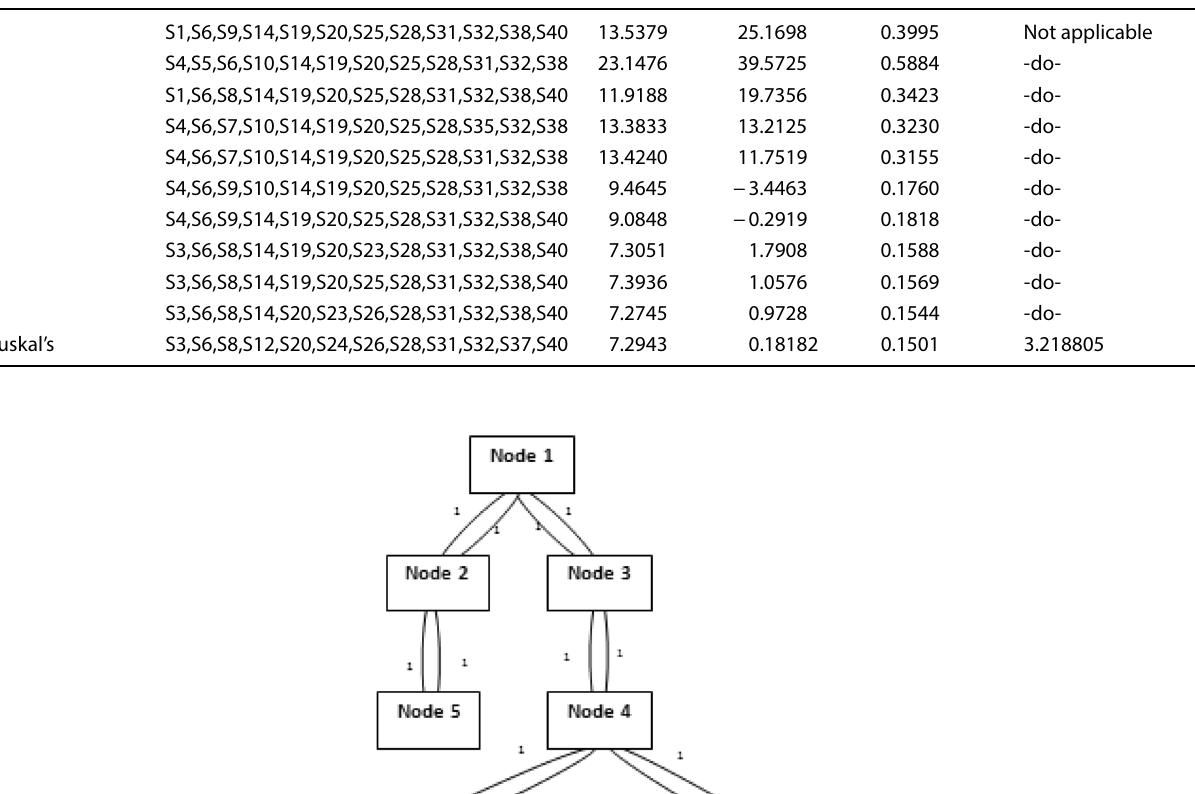
Table 8 Calculated values of L-index, P-loss, and Q-loss at 59% of base load Configuration No.